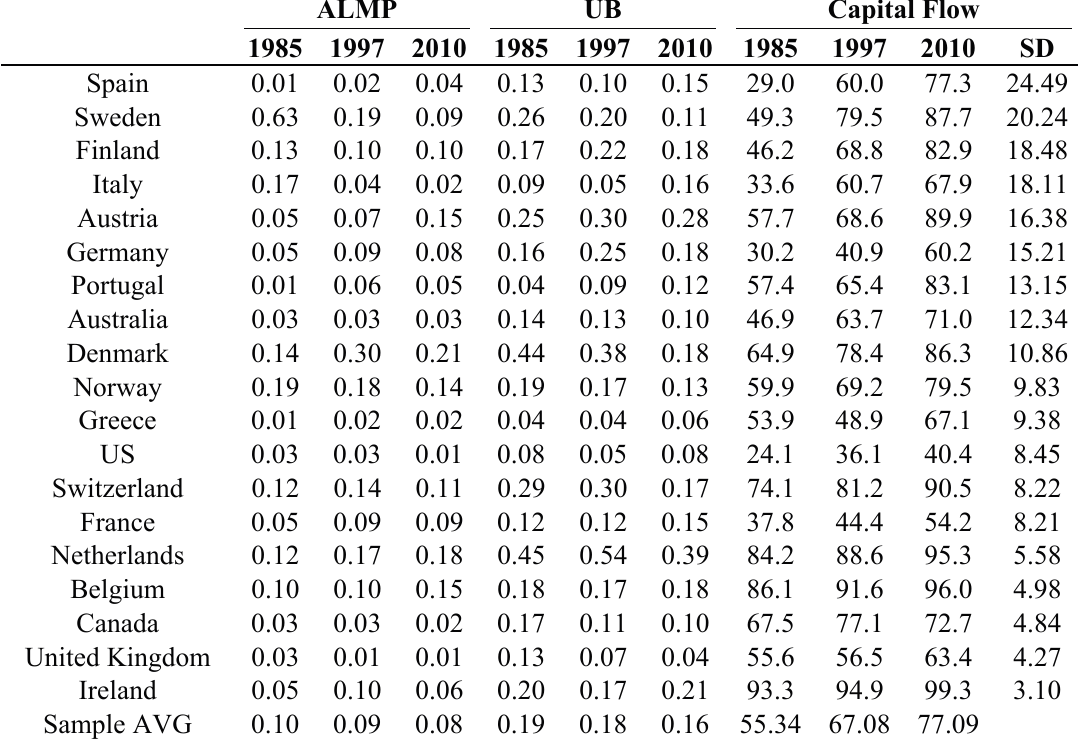
Table 1. Active labor market policy expenditure (ALMP), unemployment benefit expenditure (UB), and capital flow as percentage of GDP in 19 Western welfare states in 1985, 1997, and